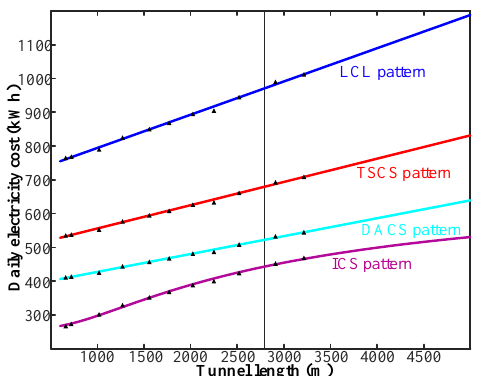
Figure 8. Energy consumption versus tunnel length for the four control strategies.